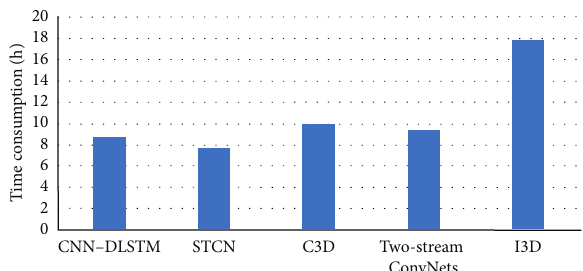
Figure 12: Time consumption of different action recognition